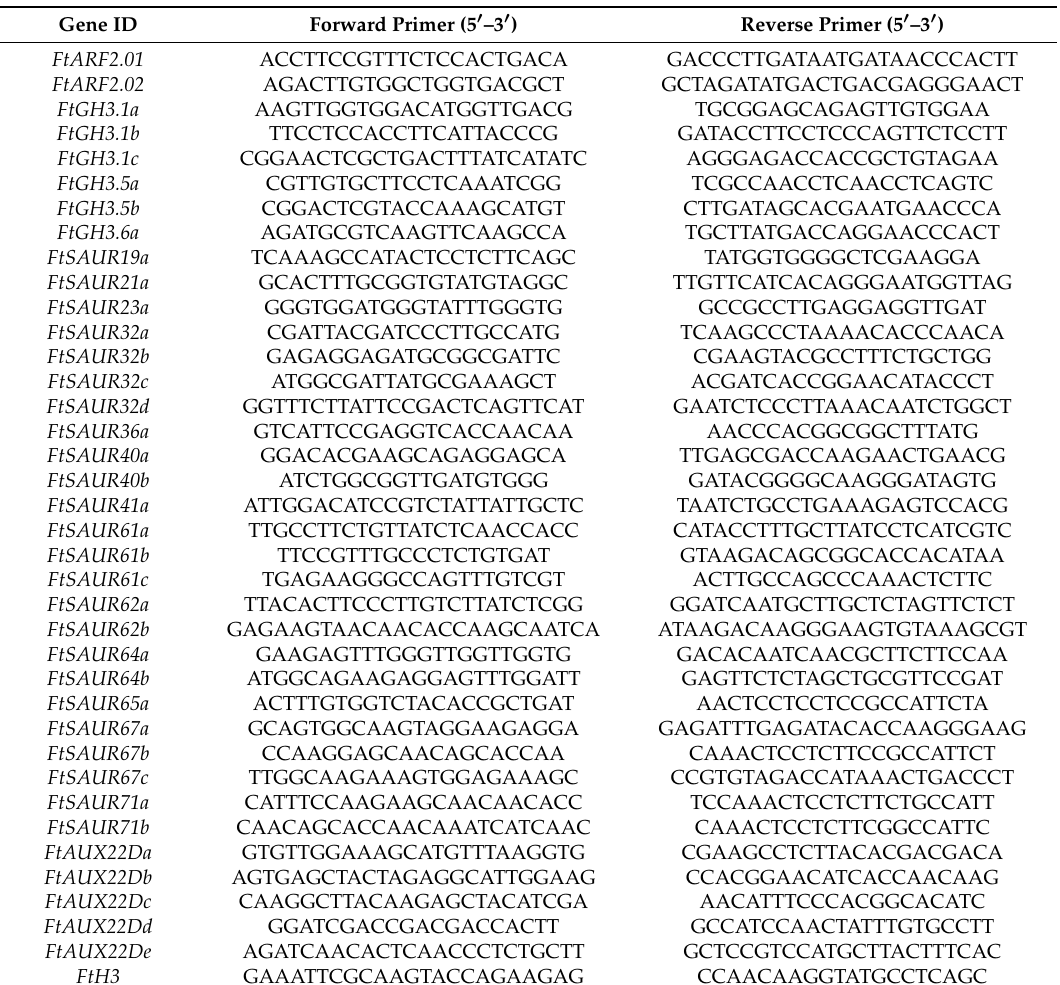
Table 5. Primers of